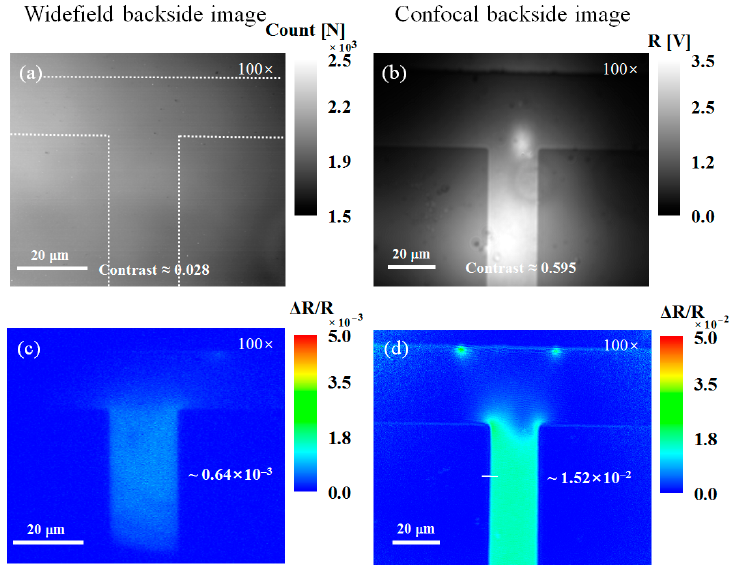
Figure 7. Backside reflection (top) and backside thermoreflectance (bottom) images of the poly-Si micro resistor obtained by ( a , c ) widefield and ( b , d ) confocal TRM systems with a 100× objective lens (NA 0.5), respectively. The dotted line in ( a ) represents the approximate region of the poly-Si resistor. The numbers in ( c , d ) indicate the Δ R/R values of the micro resistor. The solid line in ( d ) indicates the location of the profile shown in Figure 8.